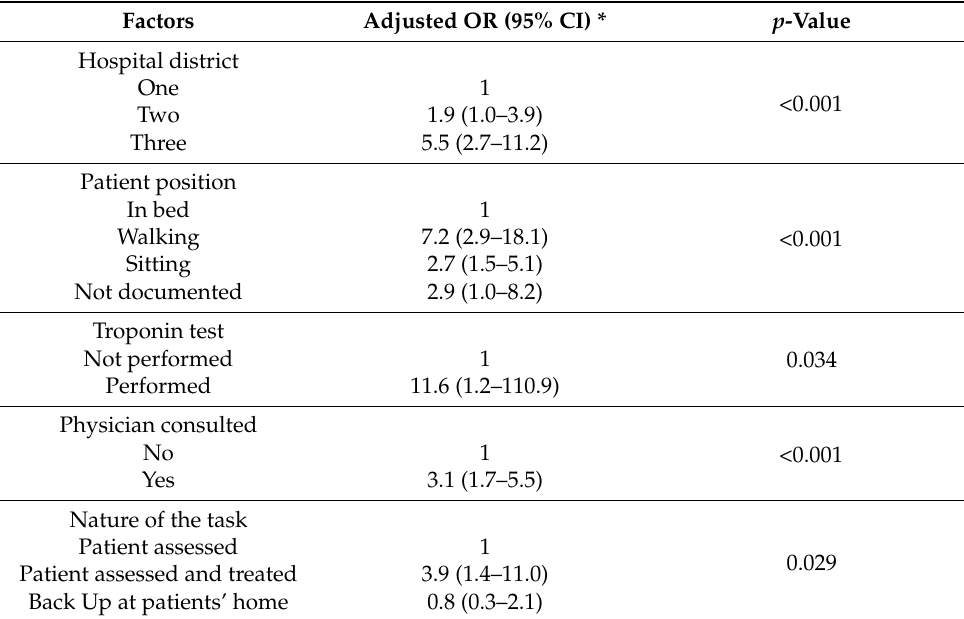
Table 5. Multivariable logistic regression of predictors of CNPs’ decisions of patient at